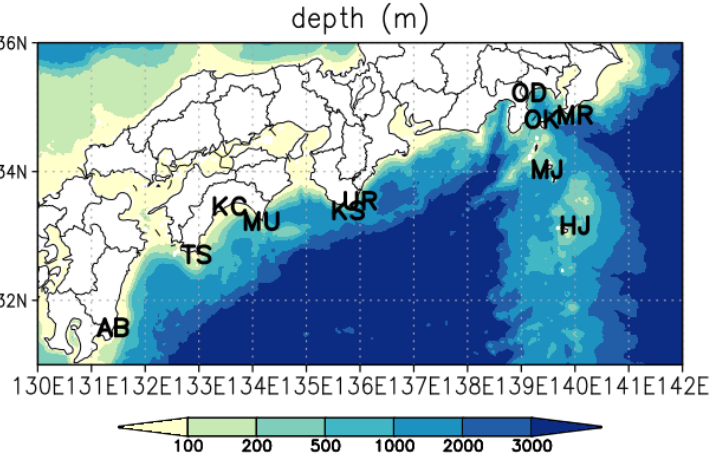
Figure 3. Modeled bottom topography south of Japan (in m, shades). Two letters denote the positions of the tide gauge sites (AB: Aburatsu, TS: Tosa Shimizu, KC: Kochi, MU: Muroto, KS: Kushimoto, UR: Uragami, OD: Ohdomari, OK: Okada, MR: Mera, MJ: Miyakejima, HJ: Hachijojima).